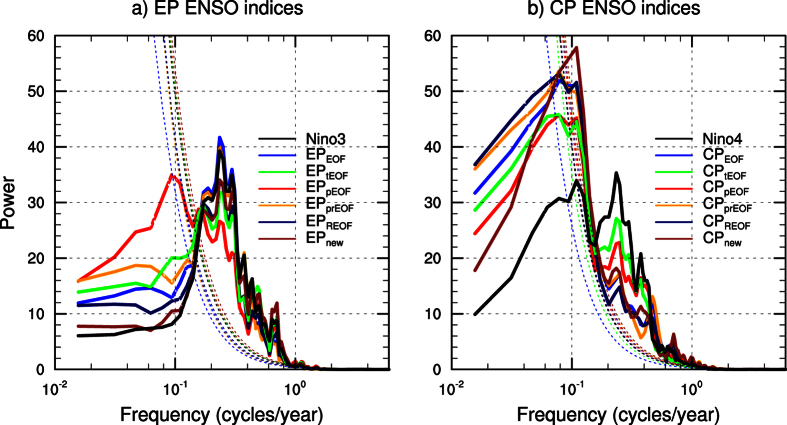
Power spectra of normalized El Niño indices during 1950–2013.Results are calculated based on (a) the detrended five-month running mean Niño3 and EP El Niño indices, and (b) the Niño4 and CP El Niño indices. The EP and CP El Niño indices (coloured lines) are computed following previous studies. Namely, the EPEOF and CPEOF indices are computed based on the conventional EOF method1. Note that the CPEOF index is very similar to the El Niño Modoki index1. The EPtEOF and CPtEOF indices are generated by further transforming the principal components of the two leading EOFs13. The EPpEOF and CPpEOF indices are also computed with the EOF method but with the EP and CP El Niño-related components being separately removed a priori (i.e., a partial EOF approach3). Similarly, the EPprEOF and CPprEOF indices are computed with the SST anomalies partially regressed onto the Modoki and Niño3 index being separately removed before performing the EOF analysis16. The EPREOF and CPREOF indices are calculated with the rotated EOF method14. Finally, the EPnew and CPnew indices are generated by a simple linear transform of the Niño3 and Niño4 indices (see the text for details). The thin dashed lines indicate the 10% significance level. Results based on non-detrended indices are very similar. Note that since all the indices are normalized prior to the spectral analysis, the displayed magnitude of the variance of each period does not represent its actual magnitude. This figure is created using NCAR Command Language software package version 6.3.0 (https://www.ncl.ucar.edu).